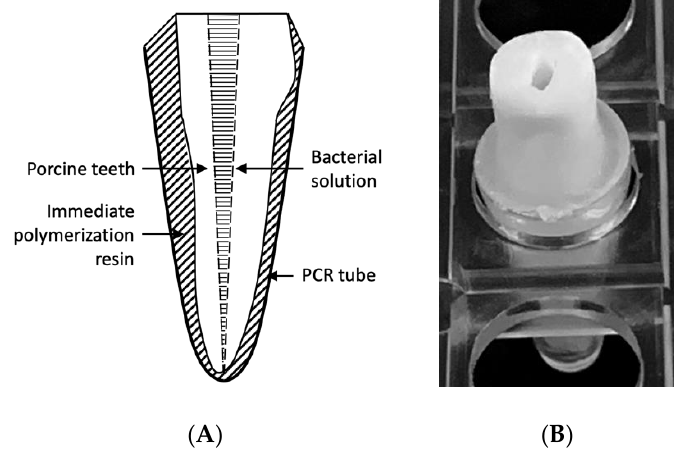
Figure 7. Preparation of the infected root canal model based on porcine teeth. ( A ) Schematic diagram of the infected root canal model. ( B ) Photograph of the infected root canal model. The root was separated from the first or second molar, and the length was adjusted to 13 mm. The root canal was cleaned mechanically and chemically, and then the root was autoclaved before it was fixed in a PCR tube with immediate polymerization resin. A bacterial solution of E. faecalis was inoculated in the root canal and incubated for 21 days at 37 °C.